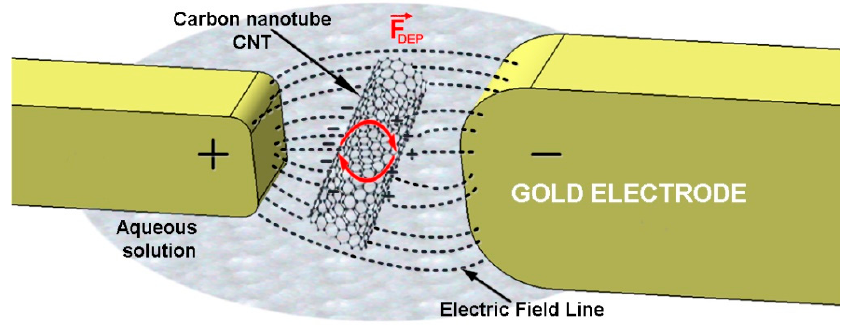
Figure 13. CNT undergoing DEP motion